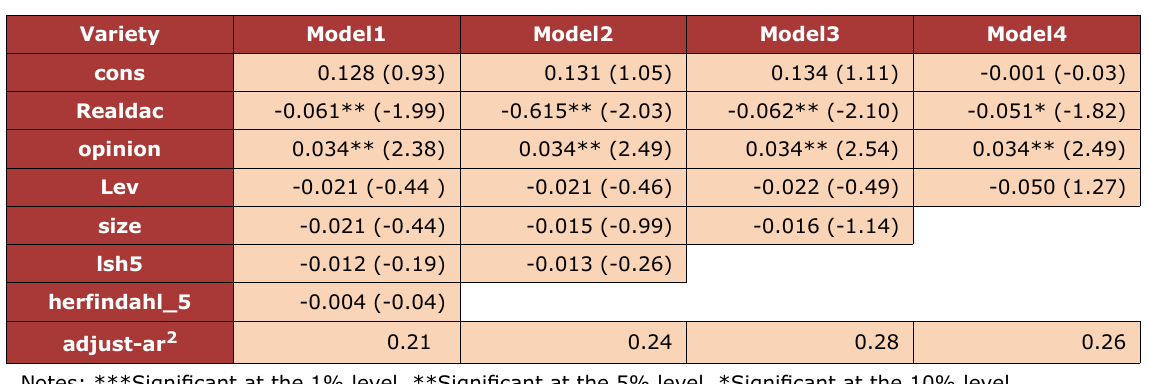
Table 4 ． Empirical results of consequences of real earnings management on subsequent performance of